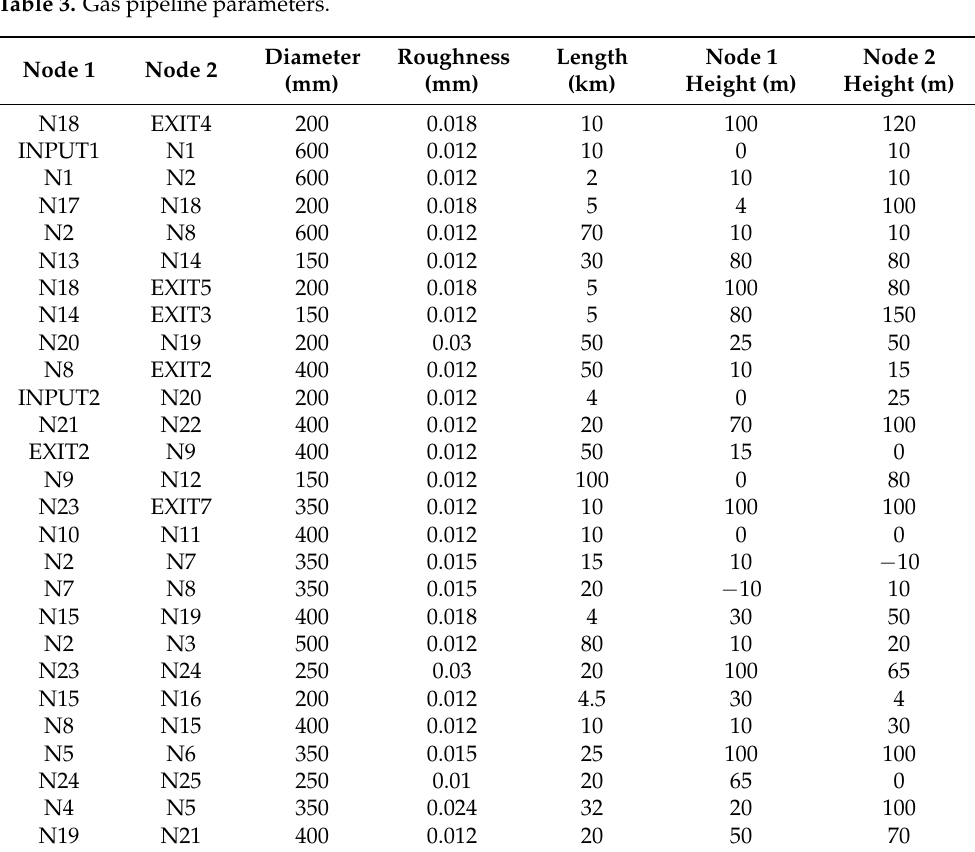
Table 3. Gas pipeline